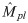
Data set M vs. v6M (or 10−2
D) and the model outputs M^pl for men patients’ population.